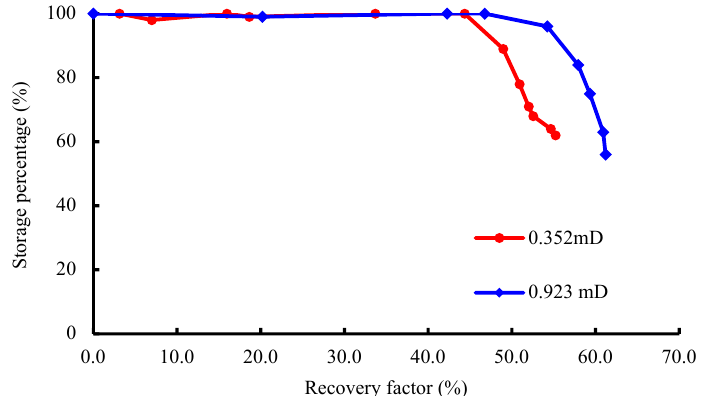
Figure 6. Relationship between recovery degree and storage